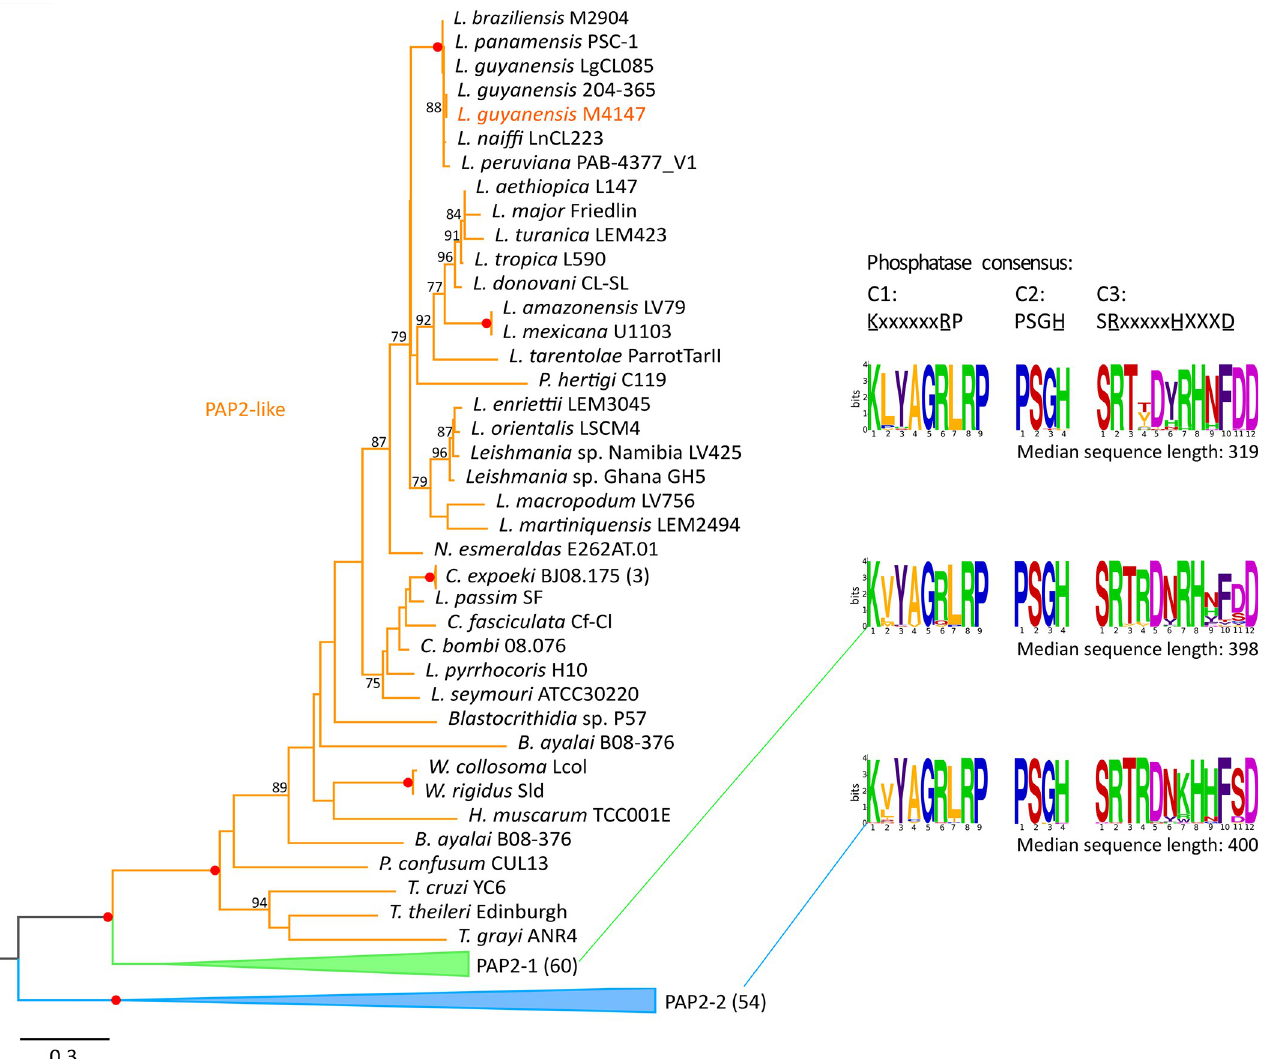
Fig 1. Maximum-likelihood phylogenetic tree of 155 PAP2 and PAP2L sequences of 50 kinetoplastid species. Only bootstrap supports over 75% are shown (red dots indicate maximal supports). The analyzed PAP2L of L . guyanensis is colored in orange. The tree is divided into three main clades colored in orange (clade containing the PAP2L investigated here and L . major Friedlin LmjF . 18 . 0430 ),green (clade containing LmjF . 18 . 0440 and other 59 PAP2-related sequences, labeled PAP2-1), and blue (clade containing LmjF . 19 . 1350 and other 53 PAP-related sequences, labeled PAP2-2). Numbers of sequences within collapsed clades are shown in brackets. Weblogos of the PAP2 superfamily (PF01569) phosphatase domain are shown on the right for the PAP2L (top), PAP2-1 (middle), and PAP2-2 (bottom) groups. Median sequence length for the three major clades is also shown. Residues of amino acids are colored in accordance with their chemical properties: positive charged side chains are in green; negative charged side chains are in pink; polar uncharged side chains are in red; non- polar hydrophobic side chains are in orange; aromatic hydrophobic side chains are in purple; and special cases are in blue. Residues involved in catalysis are underlined. See S1 Table for additional